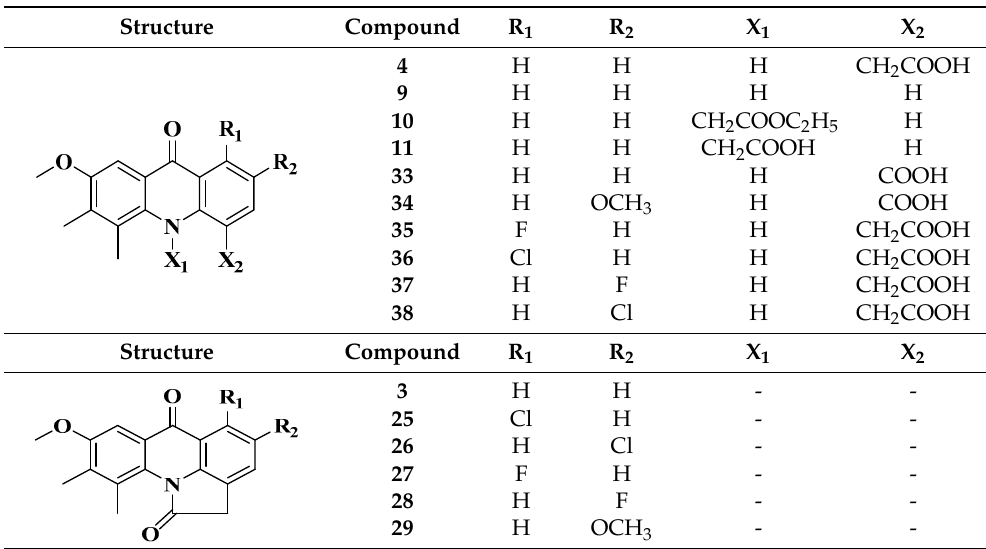
Table 1. Structures of the New Analogs of the Present Study.